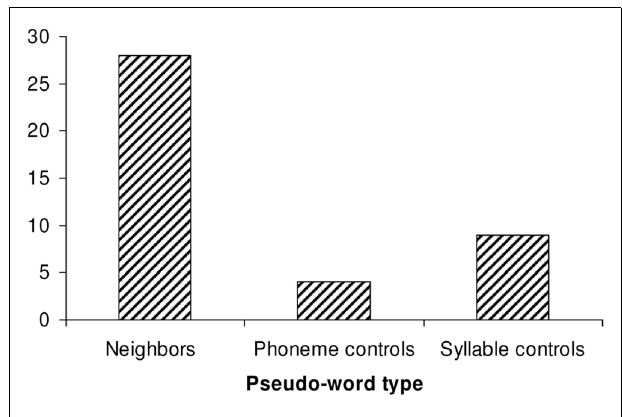
FIGURE 2 | Experiment 1: percentage of low-probability target graphemes produced in each pseudo-word spelling condition.